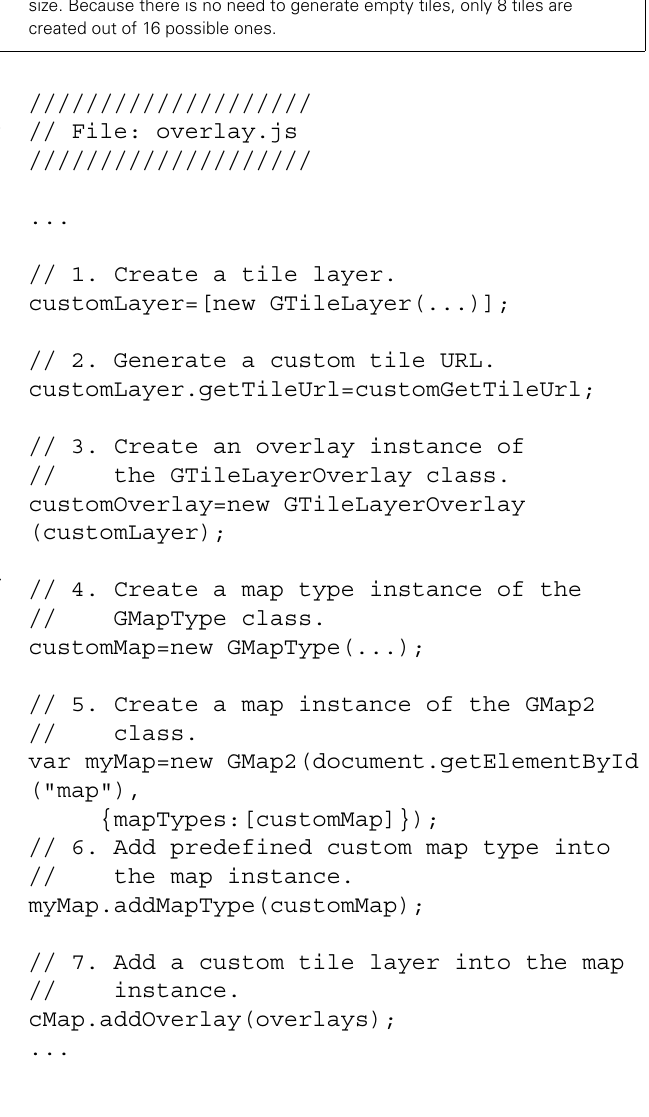
particular example shows how the original image is tiled and how the tiles are named at zoom level 2.The dark image in the middle is the image section halved down 5 times (600 × 375 pixels) to fit in zoom level 2 (1,024 × 1,024 pixels). After putting the downsized image at the center, transparent image patches (gray dashed area) are added to fill the incomplete tiles so that every tile can have the same 256 × 256